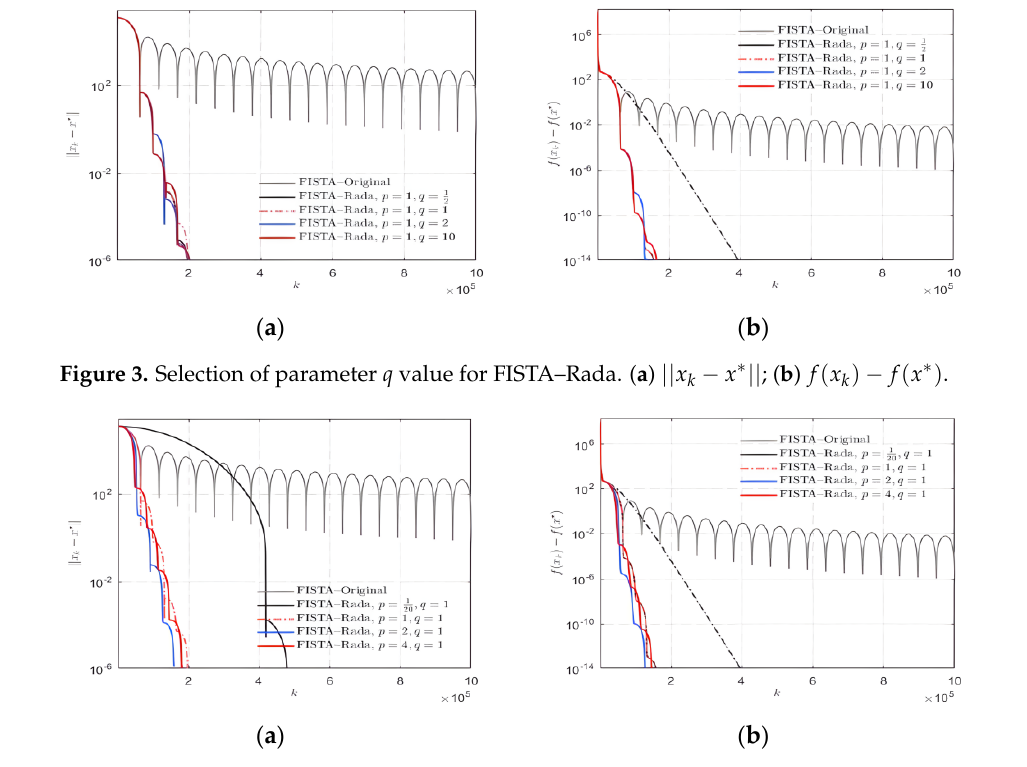
Figure 4. Selection of parameter p value for FISTA–Rada. ( a ) || x k − x ∗ || ; ( b ) f ( x k ) − f ( x ∗ )